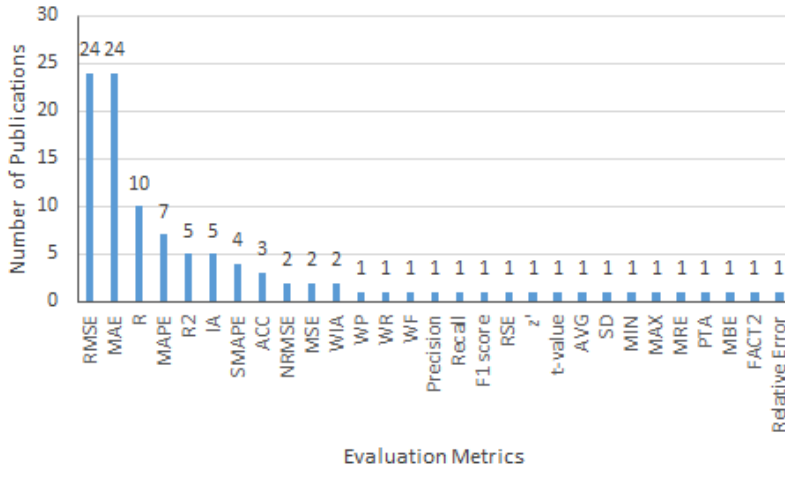
Figure 6. Used evaluation metrics.